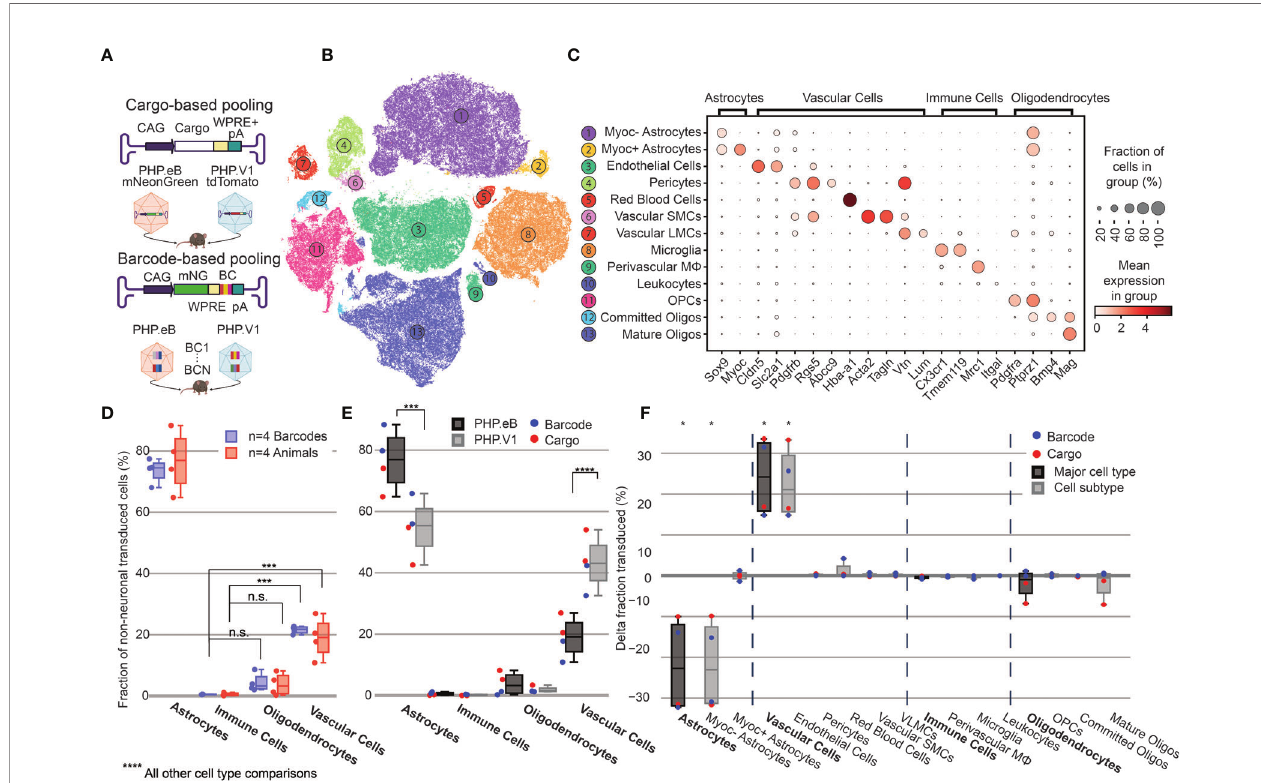
FIGURE 4 | Barcoded co-injected rAAVs reveal the non-neuronal tropism bias of AAV-PHP.V1. (A) Experimental design for comparing barcode vs cargo-based tropism pro fi ling. Animals received dual injections of AAV-PHP.eB and AAV-PHP.V1, carrying either distinct fl uorophores (cargo) or the same fl uorophore with distinct barcodes. (B) t-SNE projection of the single-cell Variational Inference (scVI) latent space of cells and their cell type classi fi cation of the 176,724 labeled non-neuronal cells across all our samples. Each number corresponds to the cell type labeled in (C) . (C) Marker genes used to identify non-neuronal cell types. Darker colors indicate higher mean expression, and dot size correlates with the abundance of the gene in that cell type. (D) The distribution of non-neuronal cells expressing transcripts from AAV-PHP.eB across 4 barcodes within one animal (blue) and across 5 animals (red). All animals received dual injections, with one of the vectors being 1.5 x 10 11 vg of PHP.eB carrying CAG-mNeonGreen. The y-axis represents the fraction of transduced non-neuronal cells that are of the speci fi ed cell type. (***P ≤ 0.001 and P > 0.05 (n.s.) is shown; all other cell-type comparisons within a paradigm were signi fi cant at P ≤ 0.0001). (E) The distribution of non-neuronal cells expressing transcripts from AAV-PHP.eB (black) and AAV-PHP.V1 (gray). Results from the different experimental paradigms are combined. Results shown are from a two-way ANOVA with correction for multiple comparisons using Sidak ’ s test comparing transduction by AAV-PHP.eB to AAV-PHP.V1 for each cell type, with adjusted P-values (****P ≤ 0.0001, ***P ≤ 0.001 is shown; P > 0.05 is not shown). (F) Within-animal difference in the fraction of cells transduced with AAV-PHP.V1 relative to AAV-PHP.eB across four animals, two from each experimental paradigm. For each cell type in each sample, the combined 2-proportion z score for the proportion of that cell type transduced by AAV-PHP.V1 vs AAV-PHP.eB is reported. Cell types with fewer than 2 cells transduced by both variants were discarded. Z scores were combined across multiple animals using Stouffer ’ s method and corrected for multiple comparisons. Cell-type differences with an adjusted P-value below 0.05 are indicated with